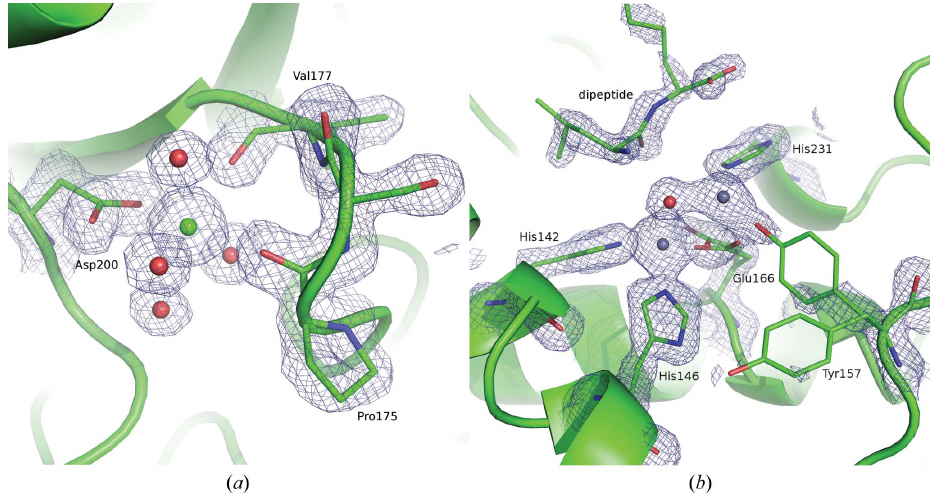
Figure 7 Exemplary 2 mF o (cid:5) DF c electron densities at 1.5 (cid:5) for the structures of proteinase K ( a ) and thermolysin ( b ) derived from crystals grown on Roadrunner I chips. The Ca 2+ -binding site of proteinase K and the active site of thermolysin with two bound Zn 2+ ions (gray spheres) are shown. Residues that are involved in ion binding and/or are functionally important are represented as sticks and labeled. For a more detailed discussion on the thermolysin structure, please see the supporting information. Julia Lieske et al. (cid:2) On-chip crystallization and ligand binding 721